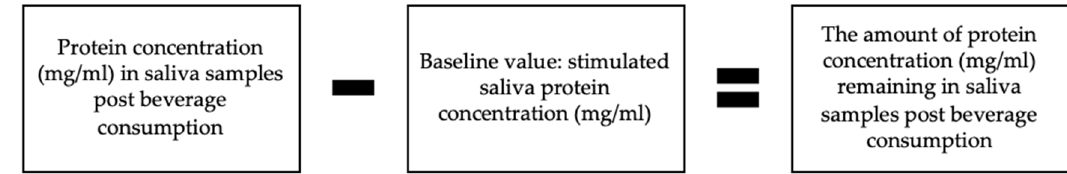
Figure A3. Summary of oral retention method calculation.